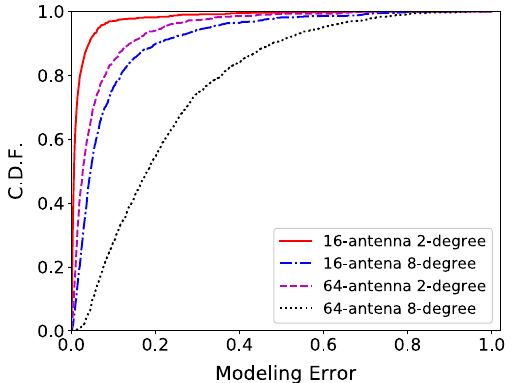
Fig. 4 The cumulative distribution function of modeling error with two different array sizes. The plot is based on simulated channels with different angle spreads,